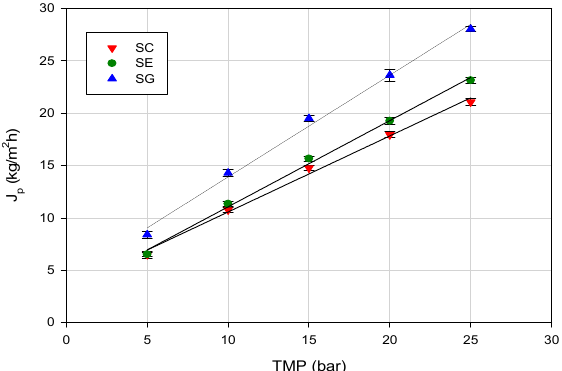
Figure 2. RO of evaporator condensate stream. Effect of transmembrane pressure (TMP) on steady-state permeate flux (operating conditions: temperature, 20 ± 1 °C; feed flowrate, 360 L/h).